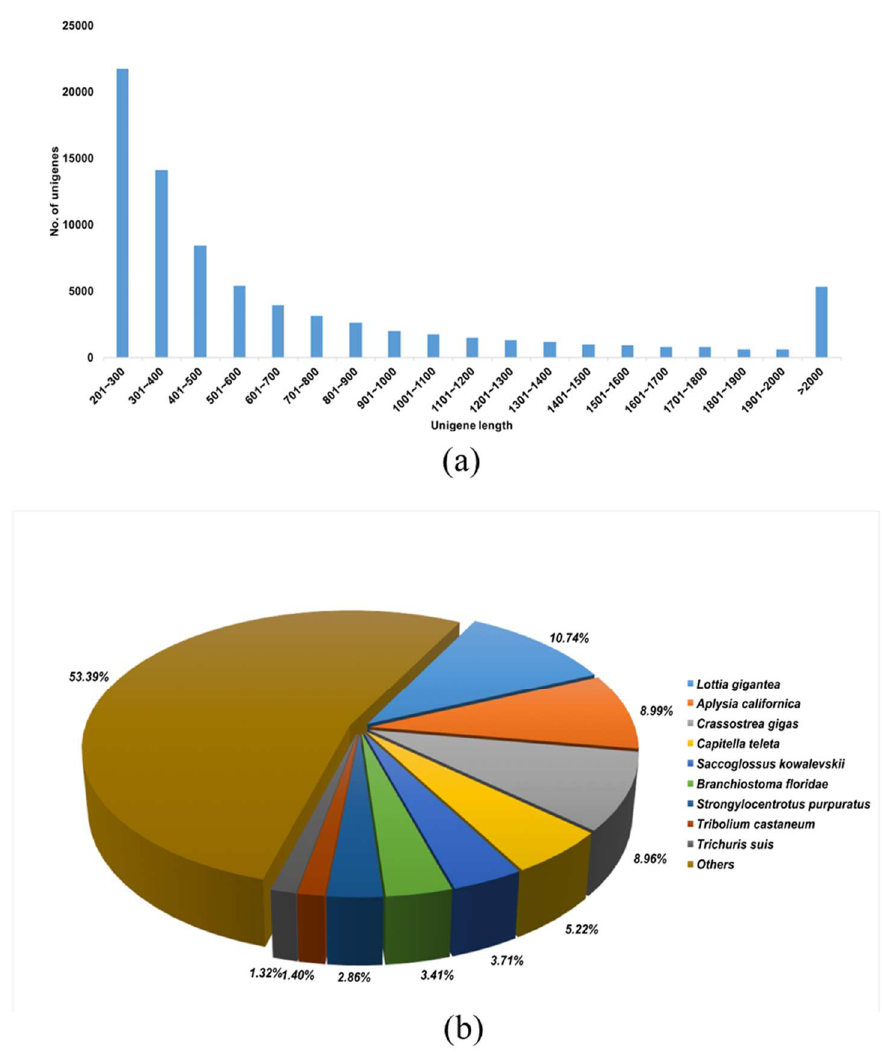
Figure 2. Overview of the Haliotis discus hannai transcriptome. ( a ) Overall length distribution of unigene reads; ( b ) Species distribution of the best of BLASTx hits of transcripts against the NCBI NR database. Table 1. Statistics of transcriptome sequencing, assembly and annotation of the Haliotis discus hannai ganglia.